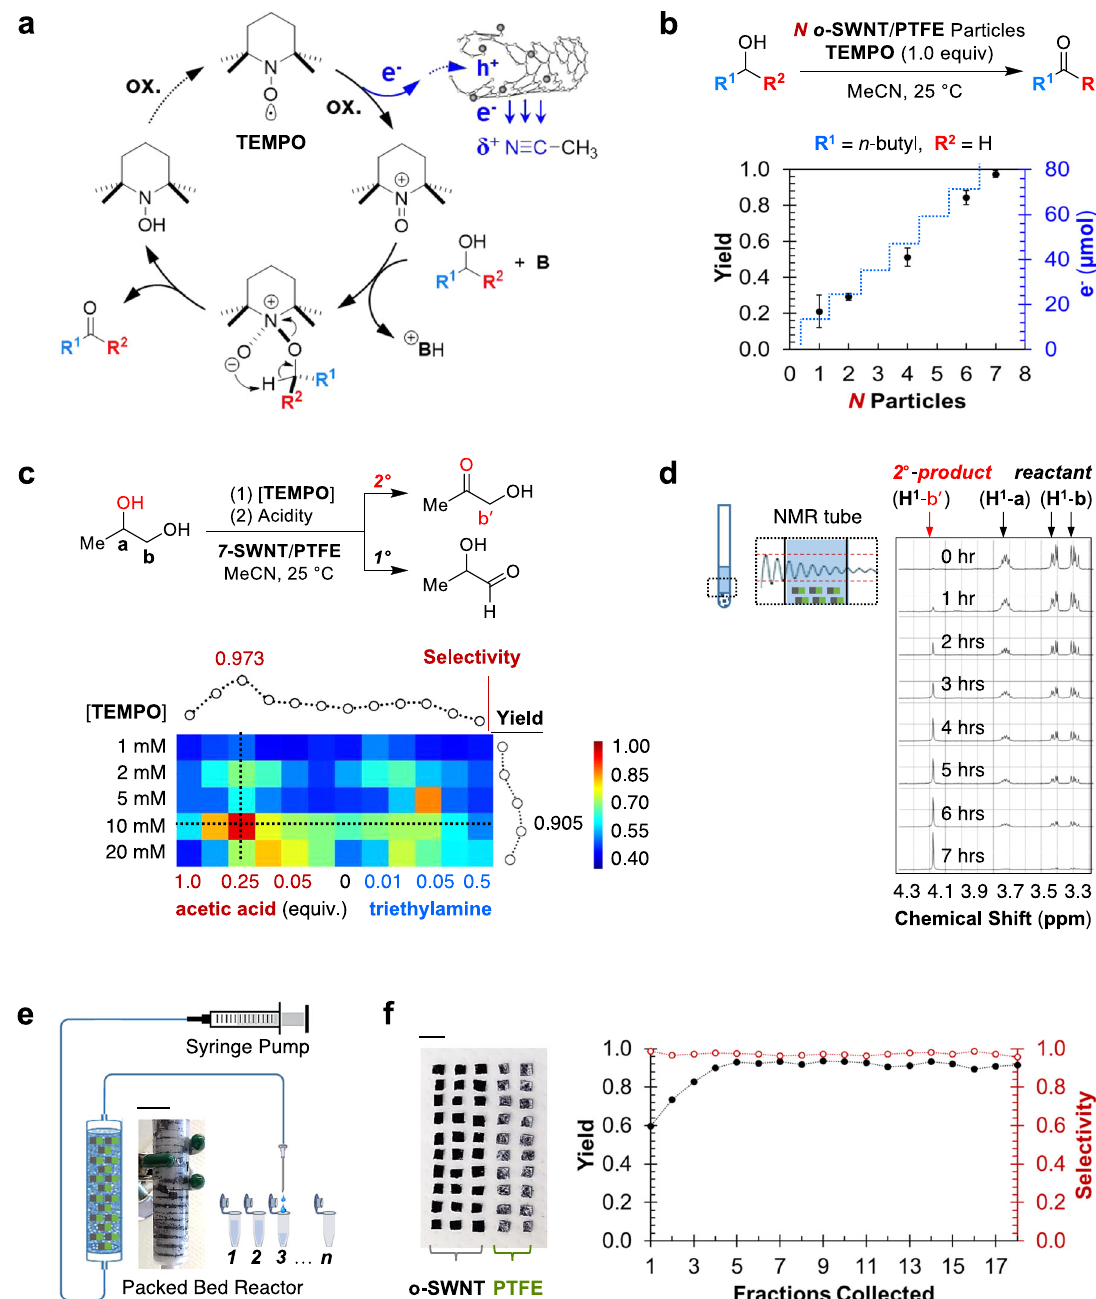
Fig. 4 In situ driven selective alcohol electro-oxidations. a Proposed mechanism for o-SWNT/PTFE particle-enabled electrochemical partial oxidation of alcohols to ketones or aldehydes (e.g., R 2 = H) in CH 3 CN, using TEMPO as a co-oxidant. b Calibrated yield for the partial oxidation of amyl alcohol to amyl aldehyde electrochemically using various numbers of o-SWNT/PTFE particles (1mm×2mm×2mm). Reactions are conducted under ambient condition for 8h at 20mM reactant concentration. The blue dotted lines represent the total charge capacity of each scenario where N number of generator particles are used. Error bars represent standard deviations of reaction yields collected for each number of particles used ( n = 3). c Selective oxidation of secondary (2°) over primary (1°) alcohol in 1, 2-propadiol. Top: reaction scheme of (1) TEMPO loading and (2) solvent acidity screen for the o-SWNT/PTFE-assisted electrochemical oxidation of 1, 2-propadiol, with both potential oxidation products listed. Protons ( 1 H-a, 1 H-b) of the reactant, as well as the proton ( 1 H-b ′ ) of the 2°-oxidation product (1-hydroxyl-2-propanone), are labeled accordingly. Bottom: selectivity toward the 2°-oxidation product, displayed both as a function of the TEMPO loading (vertical axis) and solvent Lewis acidity (horizontal axis, tuned via the addition of various equivalents of acetic acid — more acidic — or triethylamine — more basic). The yield along the vertical dotted line is also reported on the right hand side. d Top: schematic illustration of the in situ NMR kinetic measurement of 1, 2-propadiol oxidation using the conditions optimized in Fig. 3d. D 3 -acetonitrile (CD 3 CN) is used as the solvent. Bottom: assigned 1 H-NMR spectra for the reaction mixture. e Schematic illustration of the packed bed electrochemical reactor (PBER), in which a plug fl ow reactor column is packed with 50 standard o- SWNT/PTFE particle electricity generators (1mm×2mm×2mm), for multi-stage continuous electrochemical production of 1-hydroxyl-2-propanone. Fractions are collected with an automated system at 30min per cut. A total of 18 fractions are collected for a 9-h run. Inset: the prototype PBER used in this study (scale bar: 1cm). f Left: optical image of the 50 o-SWNT/PTFE particle generators used to construct the PBER, with either the o-SWNT side or the PTFE-coated side facing up (scale bar: 5mm). Right: calibrated yield and selectivity for 1-hydroxyl-2-propanone in each fraction collected from the PBER. NATURE COMMUNICATIONS| (2021) 12:3415 |https://doi.org/10.1038/s41467-021-23038-7|www.nature.com/naturecommunications